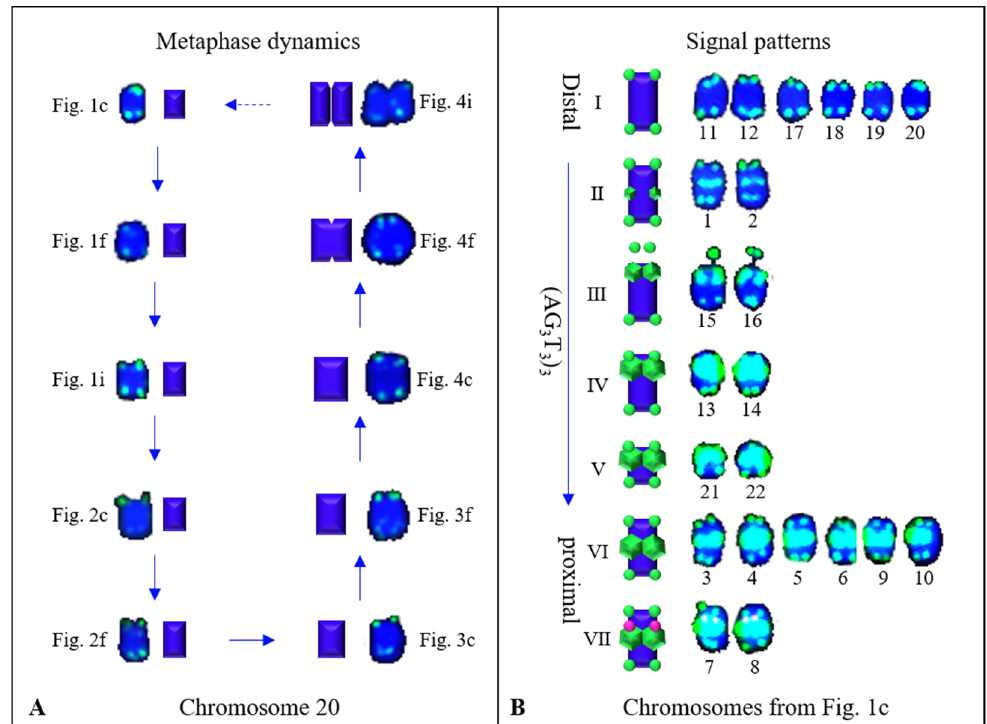
Figure 7. Dynamic metaphase progression and signal patterns of Chimonanthus campanulatus chromosomes isolated from Figure 6. The left panel (Figure 7A) shows chromosome 20 in ten spreads to present metaphase dynamics (Figure 1c,f,i, Figure 2c,f, Figure 3c,f, Figure 4c,f,i). The right panel (Figure 7B) uses the 22 chromosomes in Figure 1c to demonstrate signal patterns. The signal intensity of the distal repeat probe (AG 3 T 3 ) 3 was variable, ranging from weak on the chromosome ends to strong in the proximal regions.